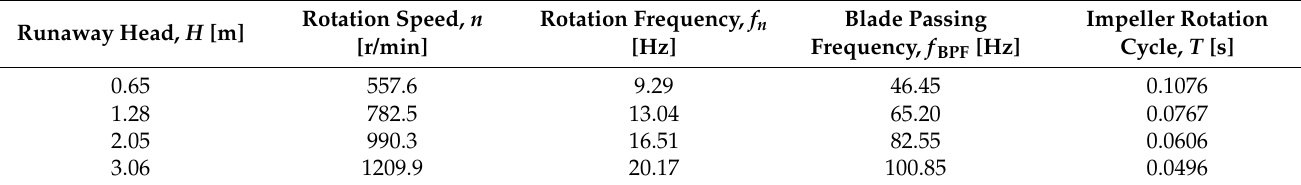
Table 3. Characteristic parameters at α = +2 ◦ with different runaway